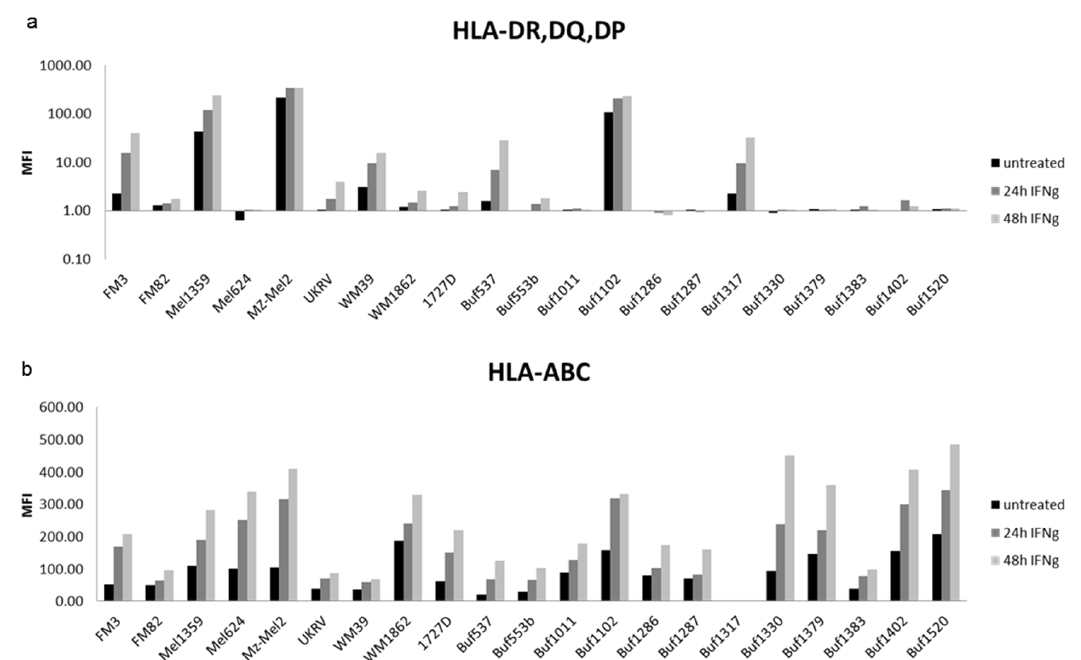
Figure 2. Heterogeneous basal and IFN- γ inducible surface expression of HLA class I and II antigens. Representative melanoma cells ( n = 21) were left untreated or treated for 24 and 48 h with IFN- γ , before flow cytometric analysis of HLA class II surface expression was determined, as described in Material and Methods ( a ). Staining with a HLA-ABC antibody served as a control for IFN- γ responsiveness ( b ). The results are presented as x-fold in MFI over the isotype control.